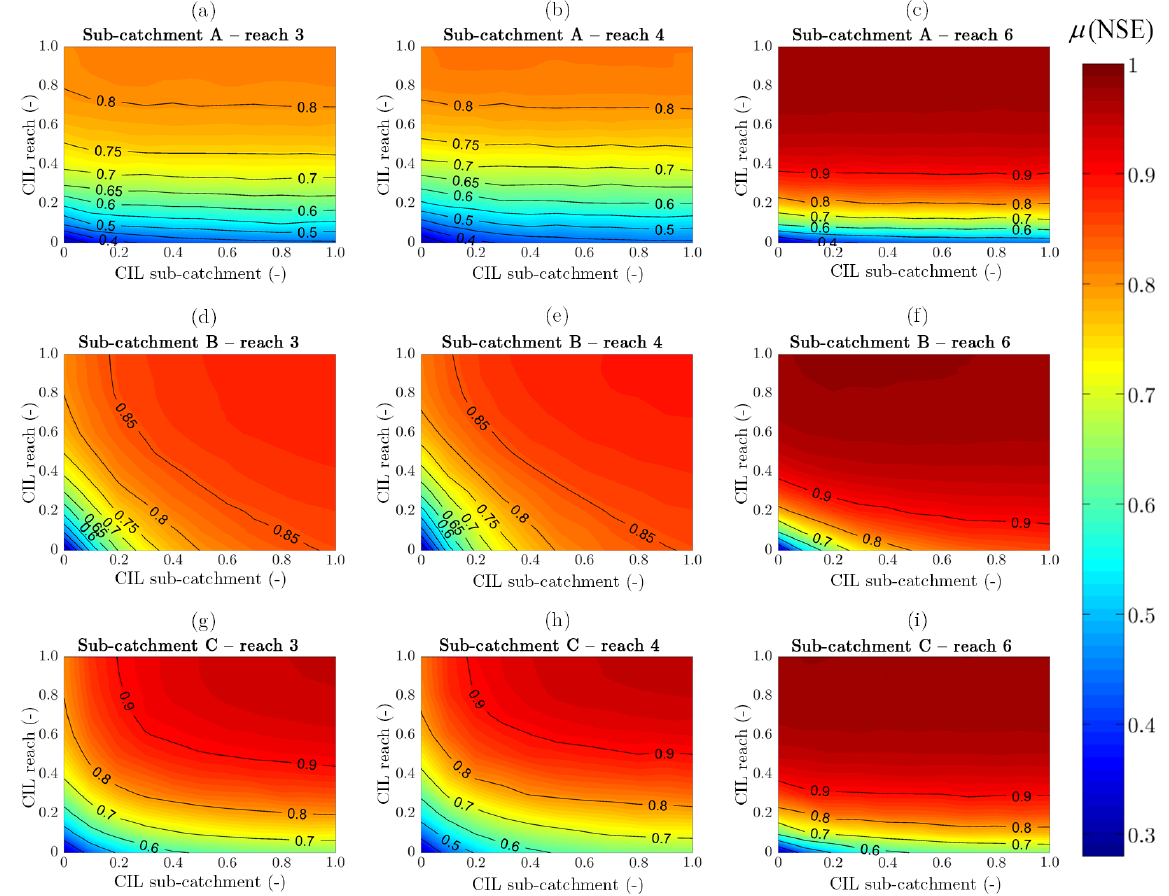
Figure 4. The µ ( NSE ) values obtained by assimilating CS observations from a combination of StSc sensors located in different sub- catchments and river reaches with 1h lead time in the case of different CIL